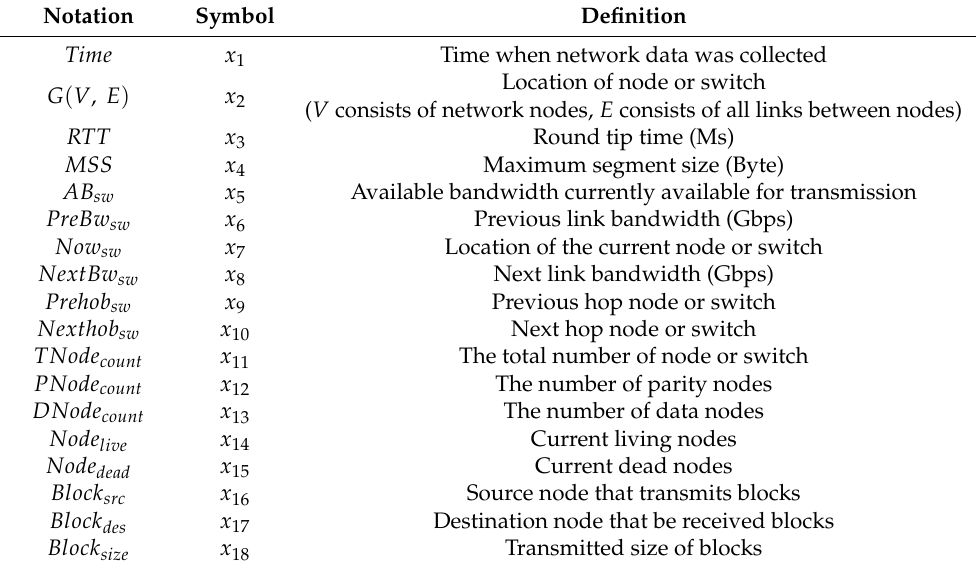
Table 1. Input parameters of DQN neural